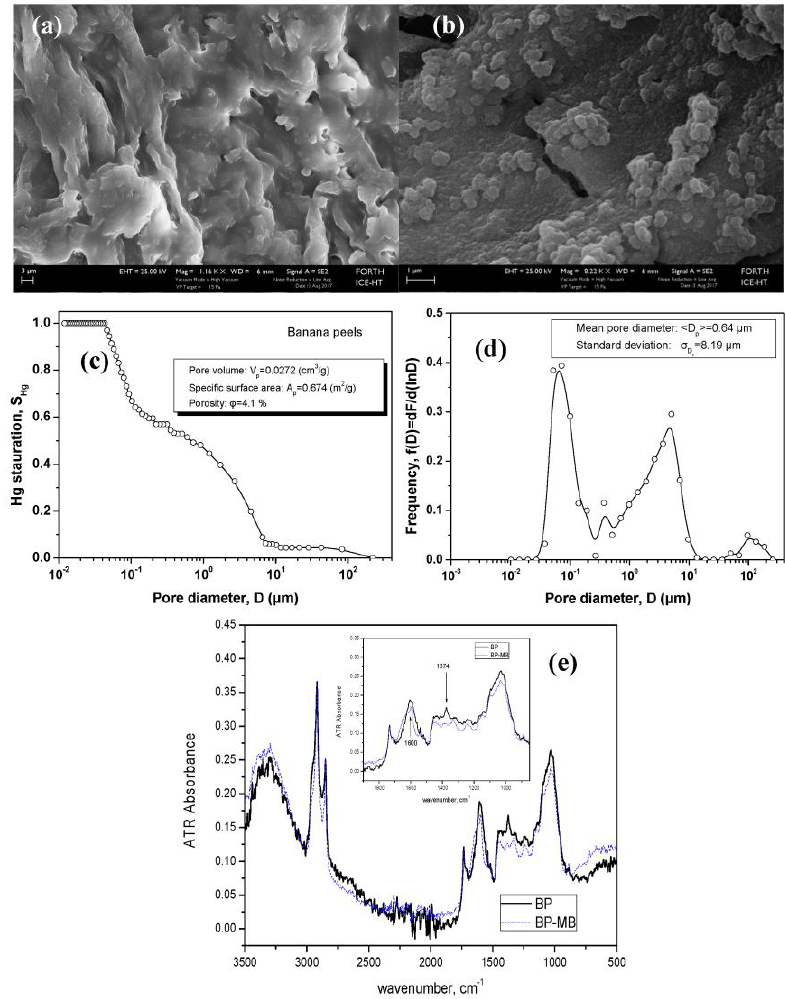
Figure 2. Representative FE-SEM images of BP ( a ) before and ( b ) after methylene blue (MB) adsorption. ( c ) Cumulative and ( d ) differential pore diameter distribution of banana peels from mercury intrusion porosimetry (MIP) data. ( e ) ATR-FTIR spectra of banana peels’ (BP) surface before and after MB adsorption.